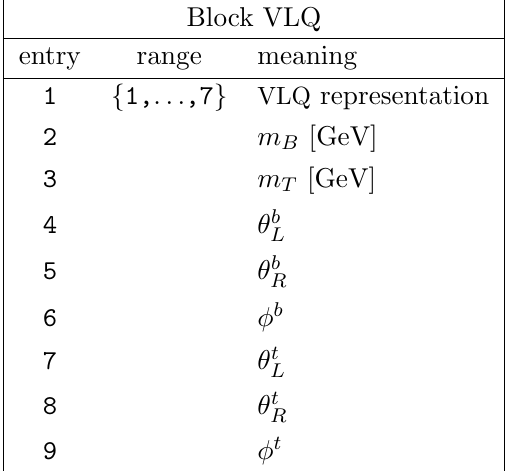
Table 19 . Setting the parameters for vector-like quarks. The number of the representation refers to eq.